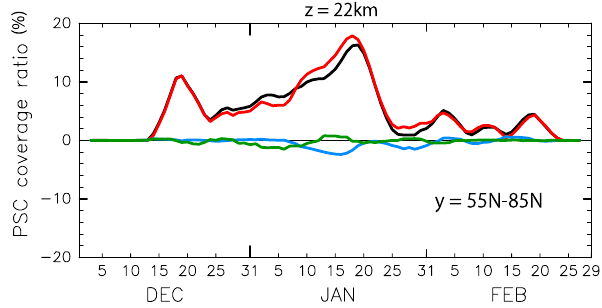
Fig. 16. The same as Fig. 11 but for the latitude range of 55 ◦ N– 85 ◦ N at an altitude of 22km in December 2007 through February 2008.